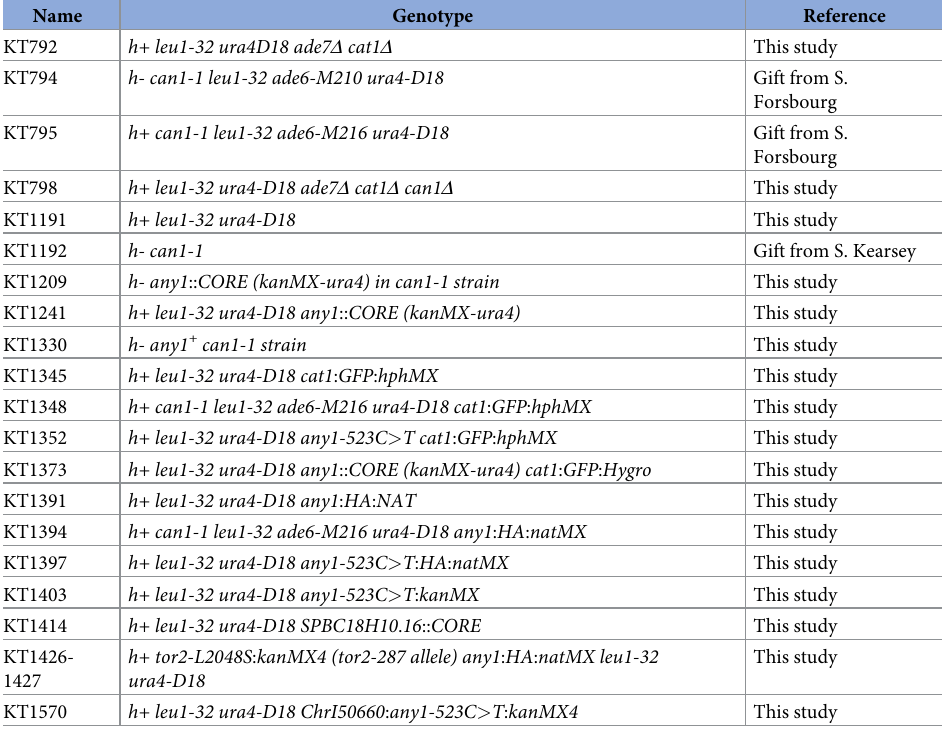
Table 1. Strains used in this